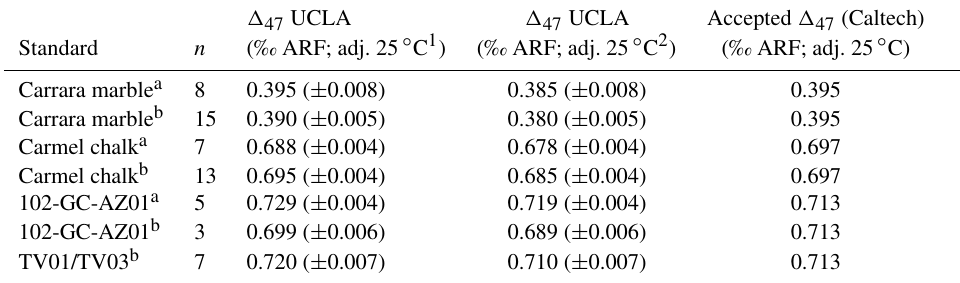
Table 3. Average standard values with standard error reported for the two periods of time when samples were measured compared to accepted values. (cid:49) 47 values are in ‰ relative to the absolute reference frame. Values are calculated using a 25 to 90 ◦ C AFF = 0.092 (denoted by 1; Henkes et al., 2013) and AFF = 0.082 (denoted by 2; Defliese et al., 2015 and Passey et al., 2010).